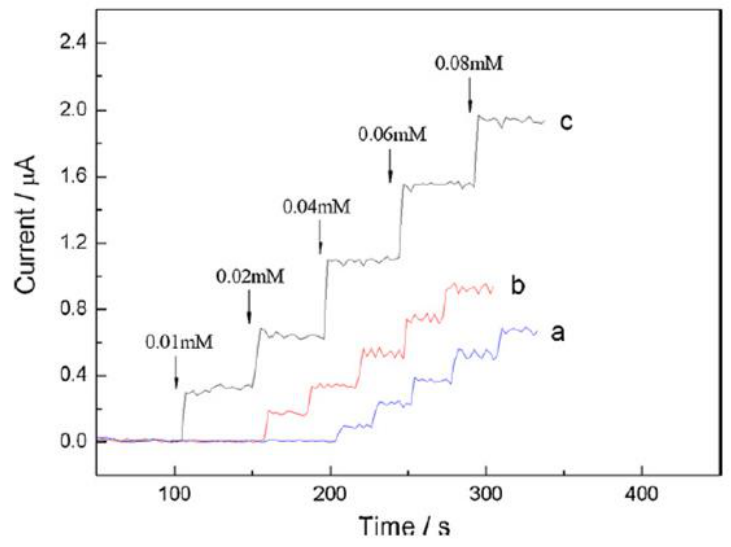
Figure 4. Current–time response of ( a ) GNP–ChOx/PDDA/Pt, ( b ) MWCNT/ChOx/PDDA/Pt and ( c ) MWCNTs/GNP/ChOx/PDDA/Pt electrodes upon successive addition of choline in 0.1 M PBS, pH 7.6, at +0.6 V vs. Ag/AgCl. Reprinted with permission from [60]. Copyright (2010) Elsevier.